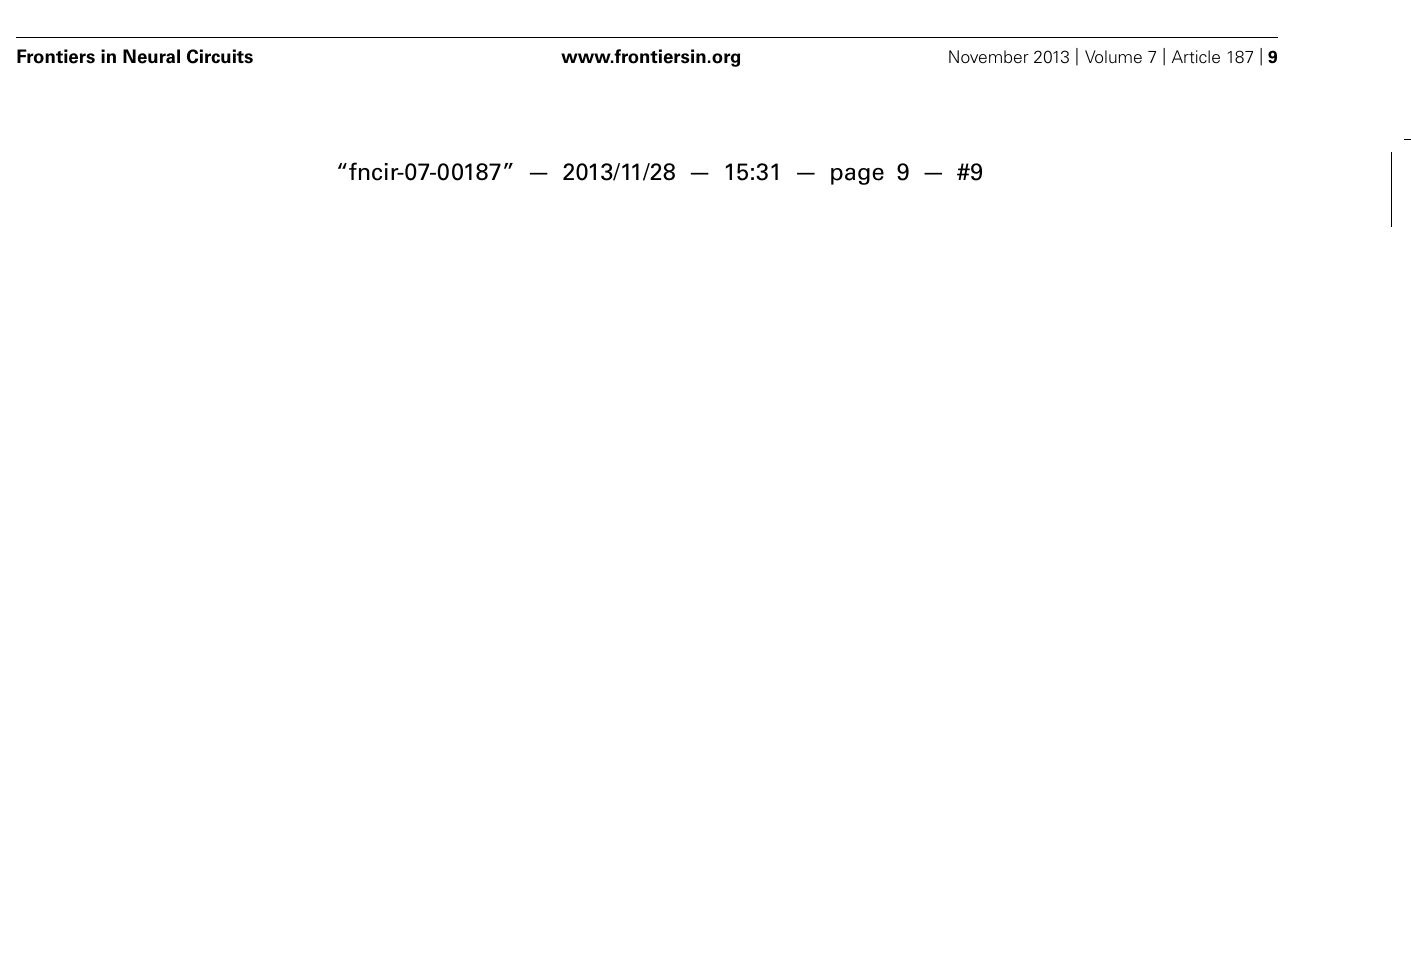
Ser/Thr kinases PDK-1 and AKT-1. Then, the activation of this pathway negatively regulates neuronal activity of the ASER neuron, thereby generating plasticity in salt chemotaxis. EGL-30/Gq, DAG, and PKC-1/nPKC pathway in the ASER neuron may positively regulate the synaptic transmission antagonize to PI3 kinase pathway. Calsyntenins expressed in the ASER neuron is cleaved and the ectodomain is released. Released ectodomain acts on either the ASER neuron itself or others to modulate salt chemotaxis